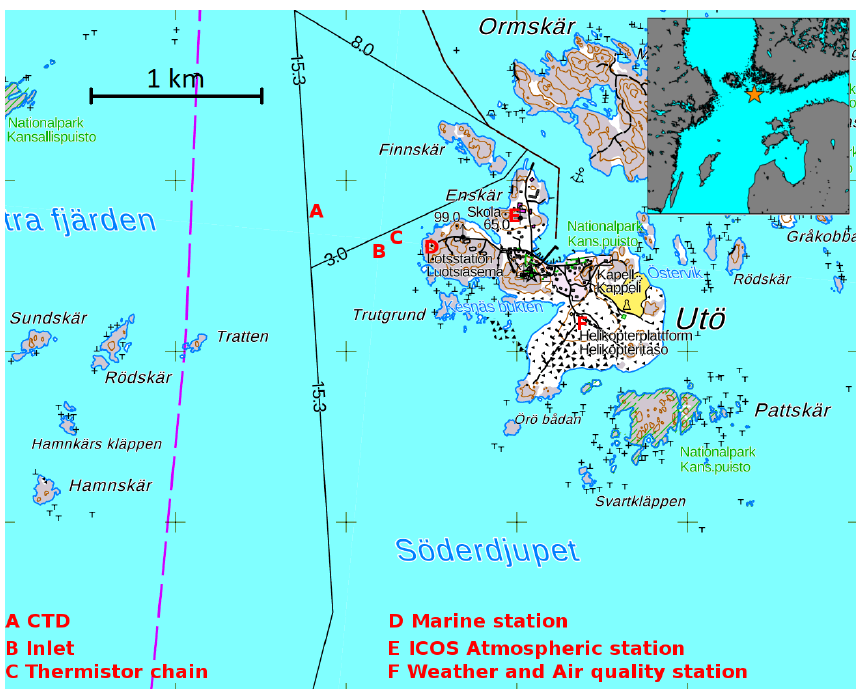
Figure 1. Sampling locations at Utö Atmospheric and Marine Research Station. The grid size (distance between plus signs) is 1km. The smaller figure in the upper right corner shows the location of Utö (orange star). The National Land Survey of Finland is acknowledged for providing the